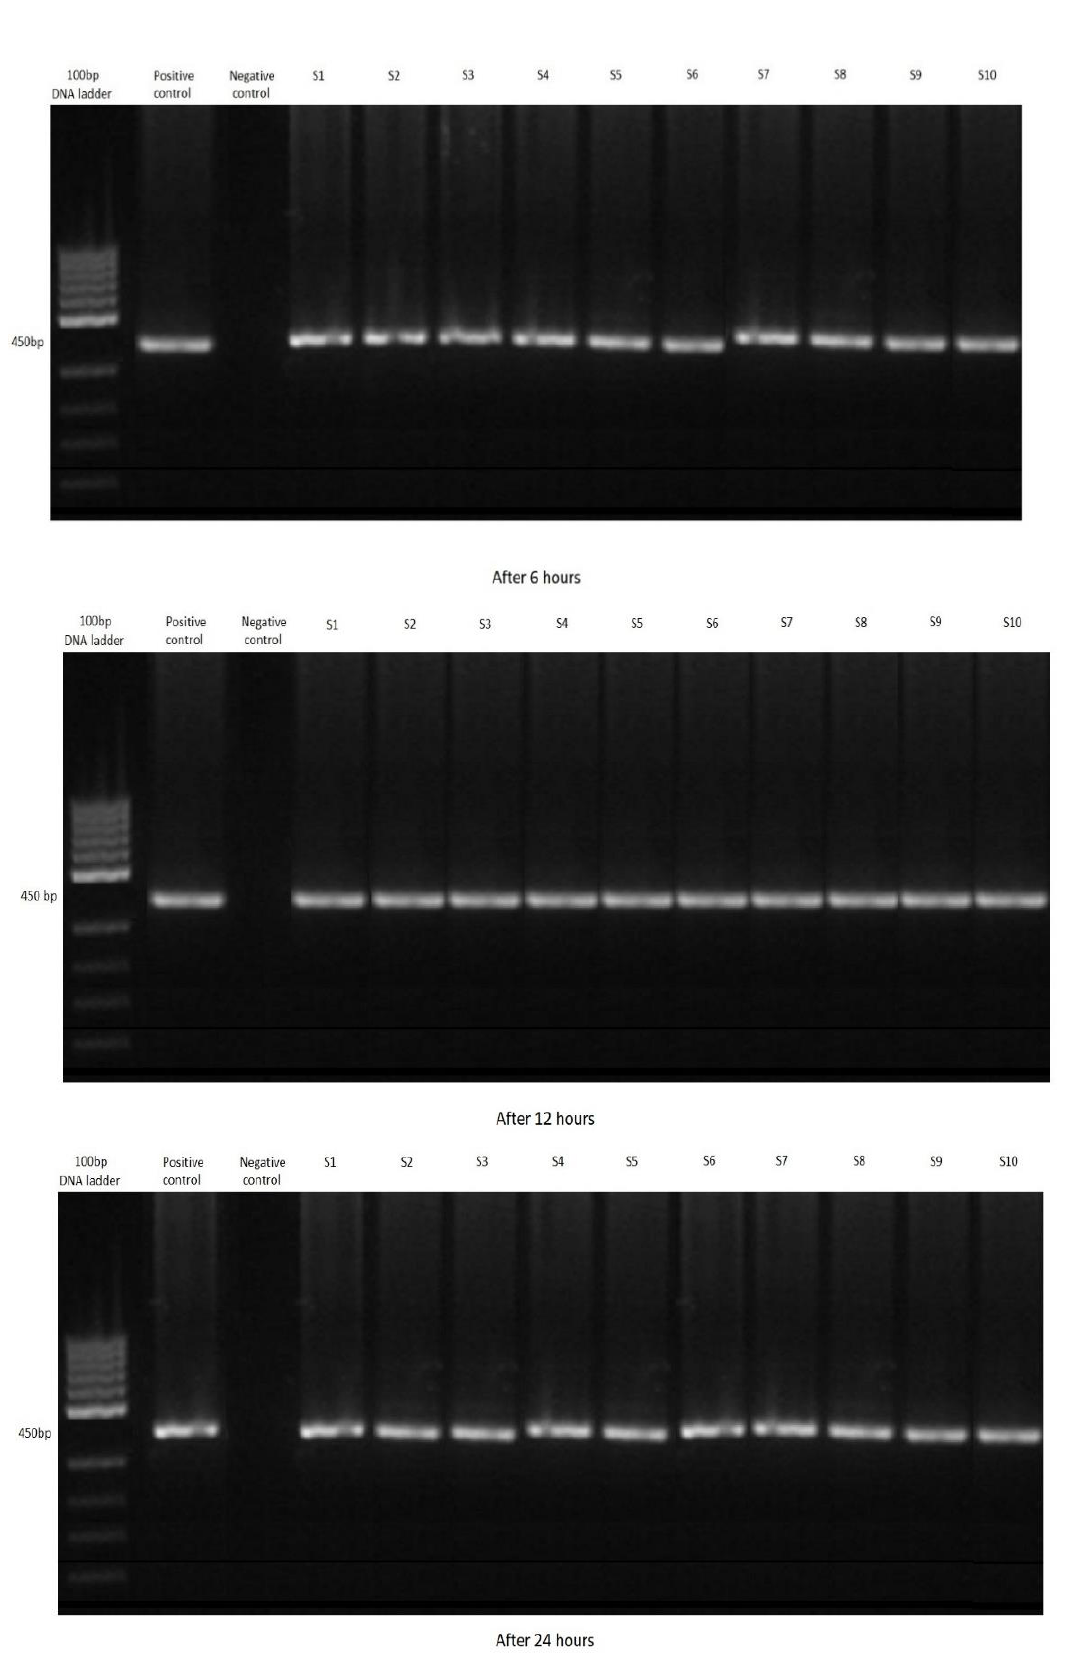
Figure 2. Agarose gel: investigated positivity of water samples for Cryptosporidium parvum with Neocaridina davidi, Group A.